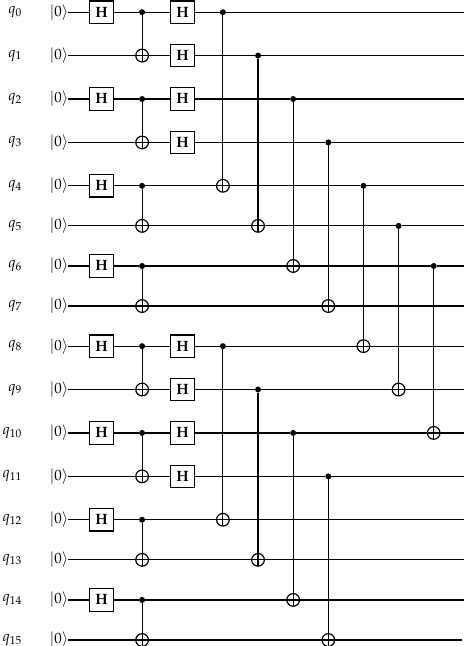
Figure 16. An example of a global update circuit for a two-dimensional PQCA.